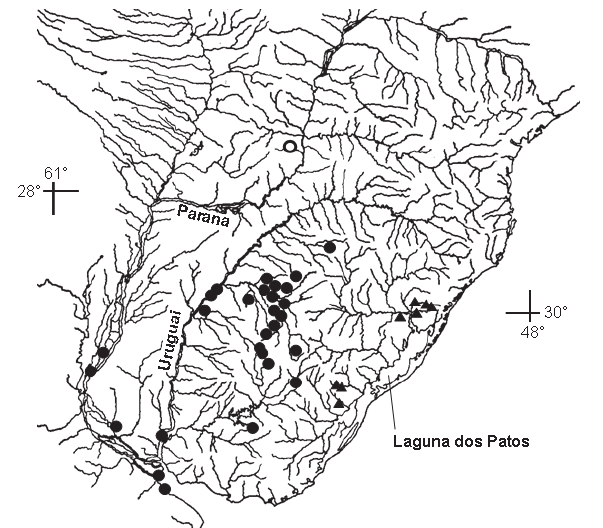
Fig. 5. Geographic distribution of Otocinclus flexilis (triangles) and O . arnoldi (dots). Open dot represents paratypes of O . mimulus . One symbol may cover more than one lot or locality.